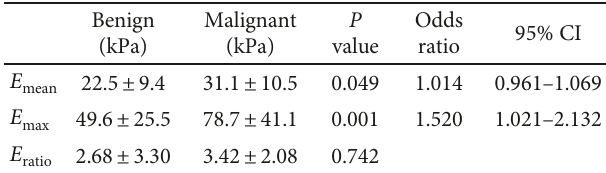
Table 4: SWE parameters for di ff erentiating thyroid